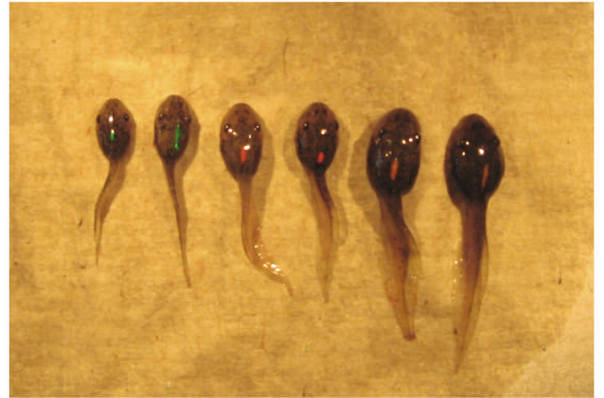
Figure 1. Wood frog tadpoles marked with subcutaneous elastomer tags for individual identification in behavioral observations.